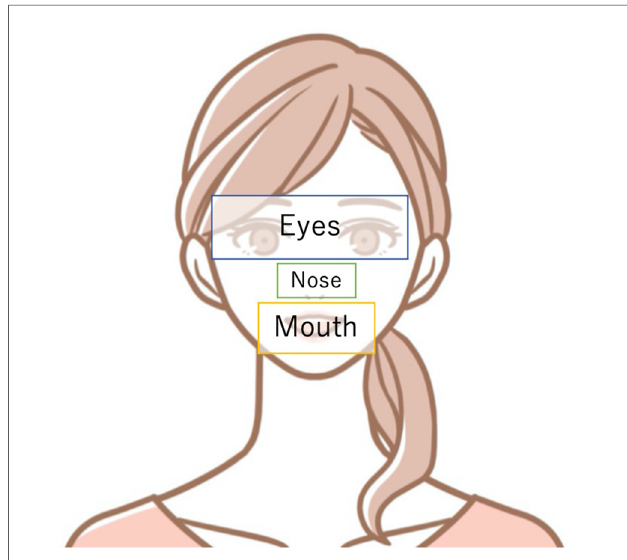
FIGURE 3 Schematic image of how AOI are set to the eyes, nose, and mouth. The eyes were set up to the eyebrows, with the nose and mouth surrounding them.